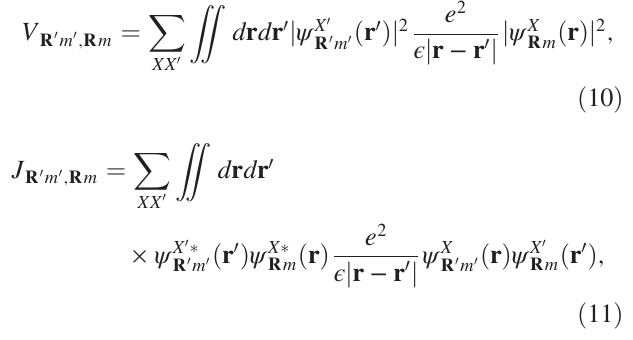
and the exchange interaction J n n Þ . The definition of M ð approx Þ n is the direct